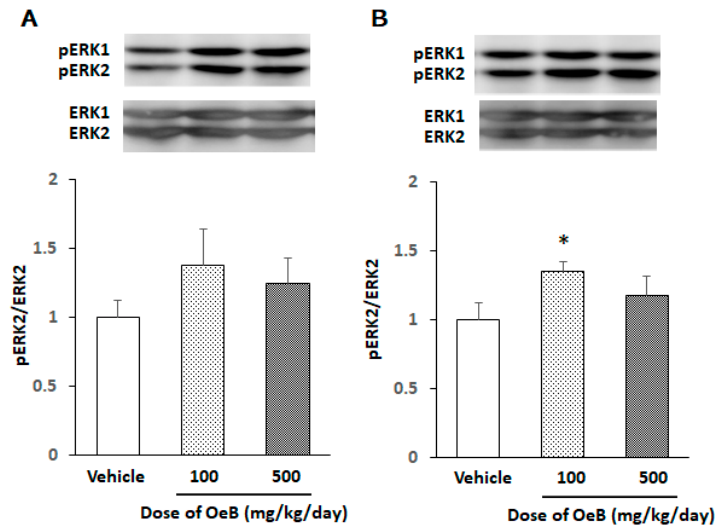
Figure 2. Effects of oenothein B on ERK2 activation in the hippocampal region of mice. Hippocampal tissues prepared on day 3 ( A ) or day 7 ( B ) after the p.o. administration of oenothein B (OeB; 100 or 500 mg/kg/day) or vehicle to mice. The density ratio of phosphorylated components to total components (pERK2/ERK2) in the vehicle-treated group (Vehicle) was expressed as 1.0. Values are means ± SEM ( n = 5 for each group). Symbols indicate a significant difference as indicated by the brackets: vs. the vehicle-treated group (* p < 0.05).